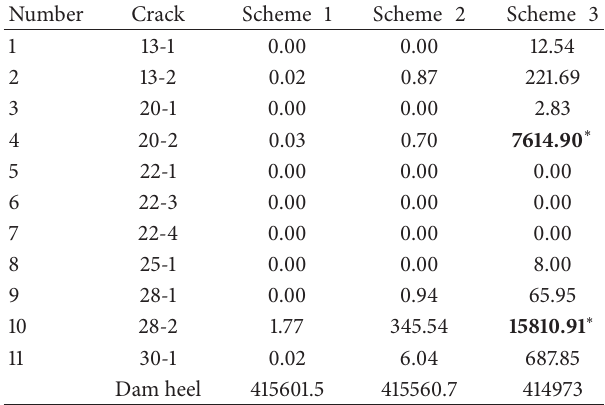
Table 5: Unbalanced force of cracks under overload 2𝑃 0 (10 4 N).